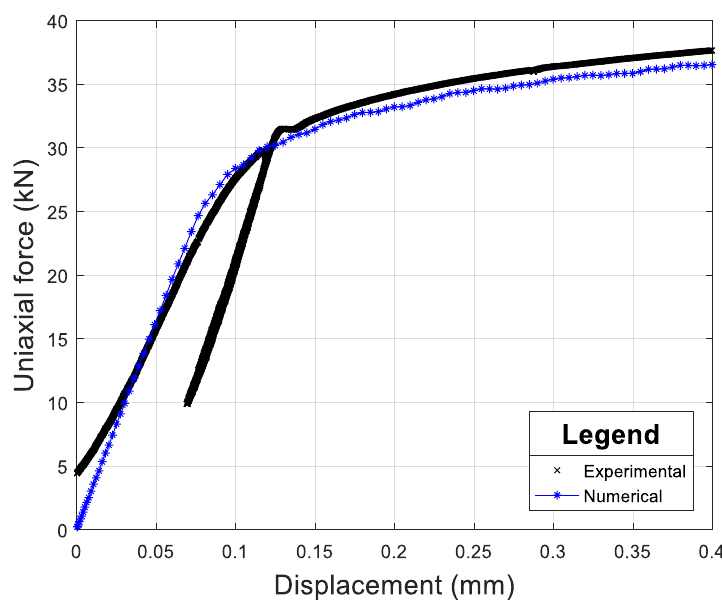
Figure 17. Comparison between the experimental force-displacement response of test (CS06) to the numerical response of a sample modelled with the constitutive law that corresponds to the behaviour identified in the present work.